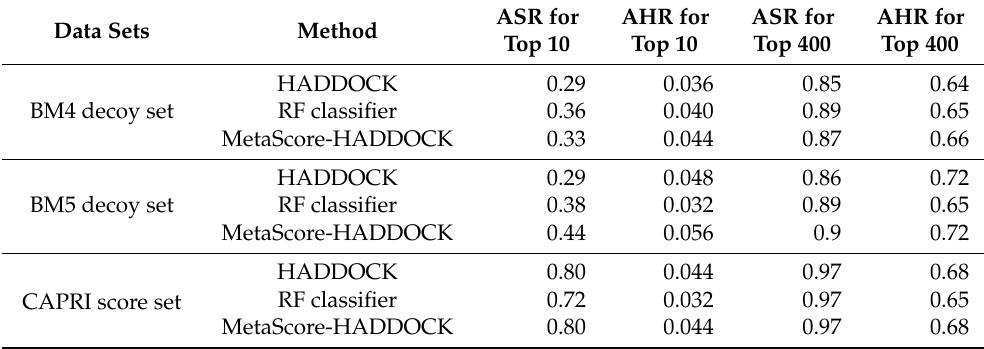
Table 1. Performance comparison of three methods, a classical scoring method (HADDOCK), machine-learning-based scoring method using RF (RF classifier), and the combined method of the two methods (MetaScore-HADDOCK) using the BM4 decoy training set, BM5 decoy set, which is a set of decoys generated by HADDOCK from the newly added docking cases to the protein–protein docking benchmark Version 5.0, and CAPRI score set [53]. Data Sets